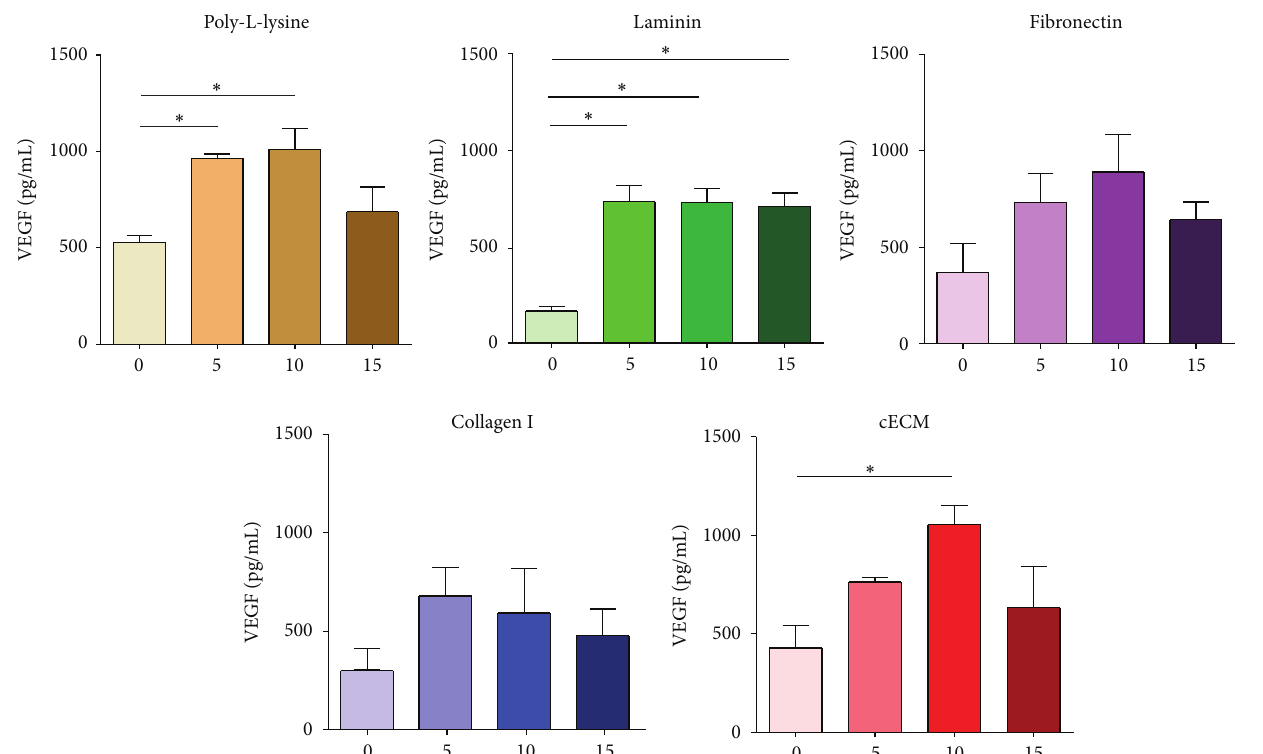
Figure2:StrainimprovesVEGFsecretioninCPCconditionedmedia.CPCswereseededoneachmatrixfor6hoursandthencyclicstrainwas applied for 24 hours. Conditioned media were evaluated by ELISA. One-way ANOVA with Tukey’s multiple comparison test; bars represent mean + SEM; ∗ 𝑝 < 0.05 ; 𝑛 = 3 -4; 𝑥 -axis: 0–15: strain magnitude (%) and VEGF: vascular endothelial growth factor